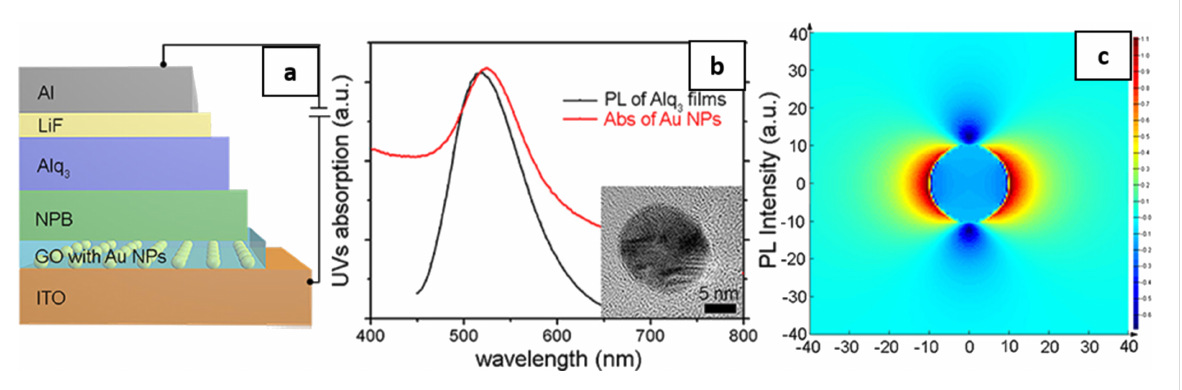
Figure 6: (a) OLED device structure with graphene oxide–AuNP inserted between ITO anode and NPB HTL. (b) The absorption spectrum of AuNP and PL emission spectrum of Alq 3 on ITO glass. The inset shows the TEM image of AuNP with a particle size of 20 nm. (c) The electromagnetic field distribution around AuNP with 20 nm diameter simulated by finite-difference time-domain modelling. Figure 6a–c was adapted from [51] (© 2018 J. Feng et al., distributed under the terms of the Creative Commons Attribution 4.0 International License, https://creativecommons.org/licenses/by/4.0/).